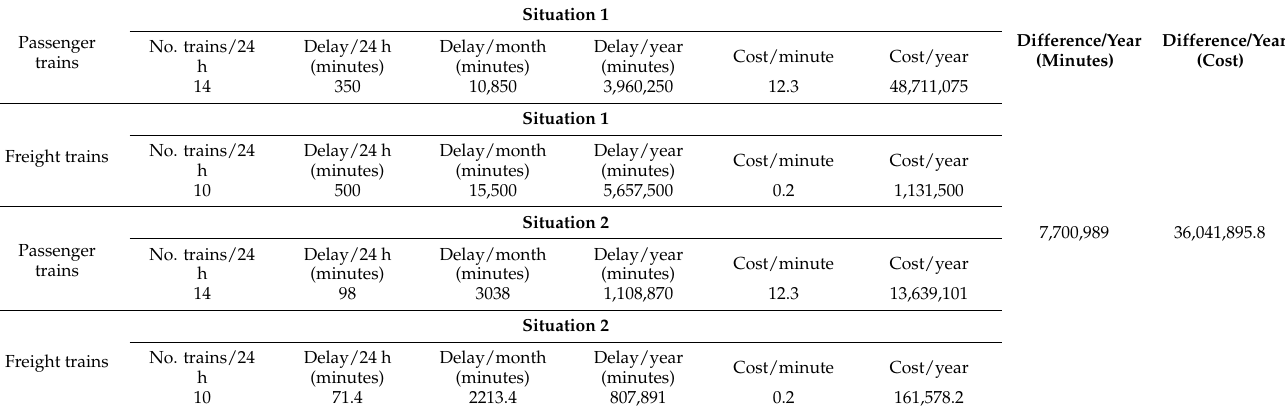
Table 1. Delay and cost data for the two analyzed